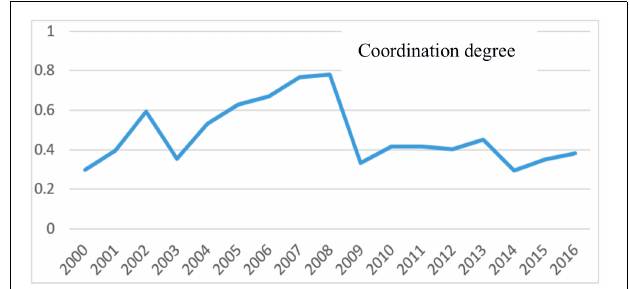
FIGURE 11 | Analysis of degree of coordination between sub-functions and total functions of cultivated land in Henan Province.